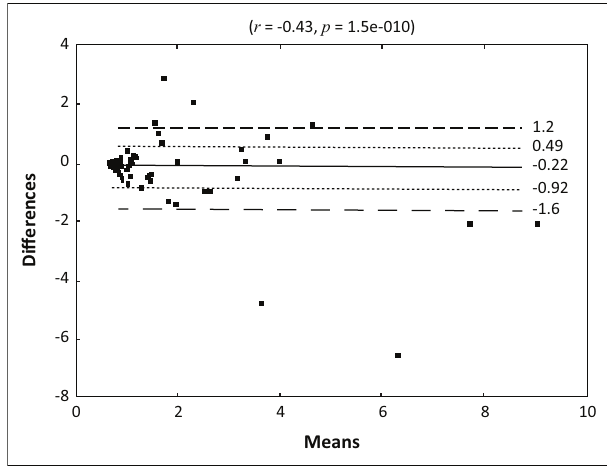
FIGURE 4: A Bland–Altman graph showing the agreement between scores of visual acuities (in min) for left eyes obtained with a Snellen chart and Spectrum LogMAR chart. Units for differences and means in Figures 2-4 are